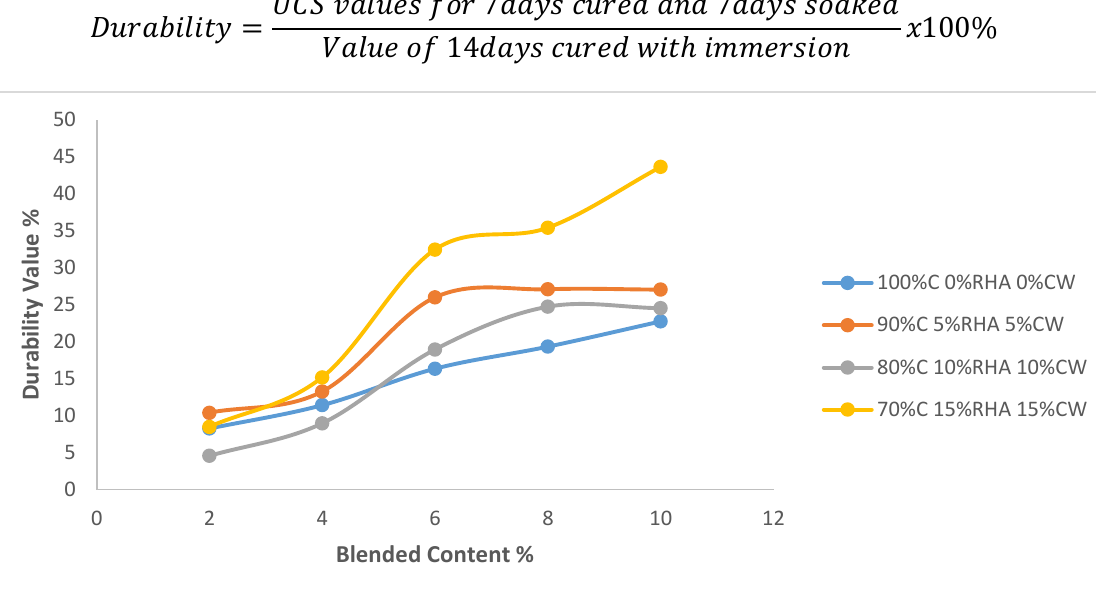
Fig. 13. Relationship between the durability values of laterite treated with (100%C 0%RHA 0%CW), ( 90%C 5%RHA 5%CW),(80%C 10%RHA 10%CW)& (70%C 15%RHA 15%CW) blend of